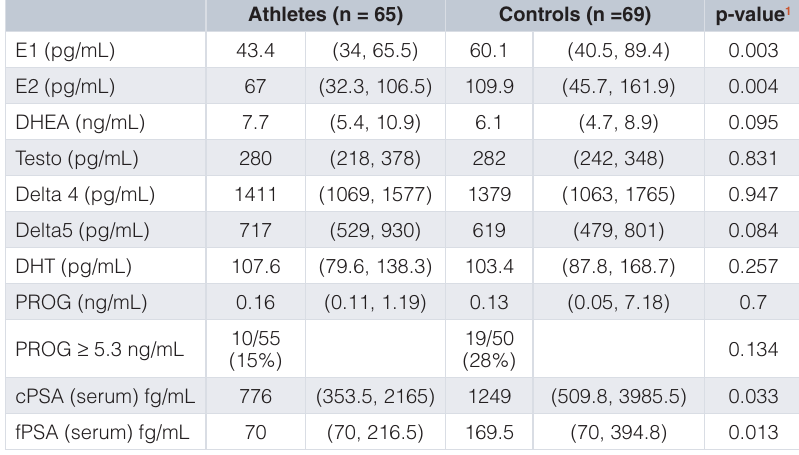
Table 2. Median (25th, 75th percentiles) steroid and PSA values among athletes and controls who do not use